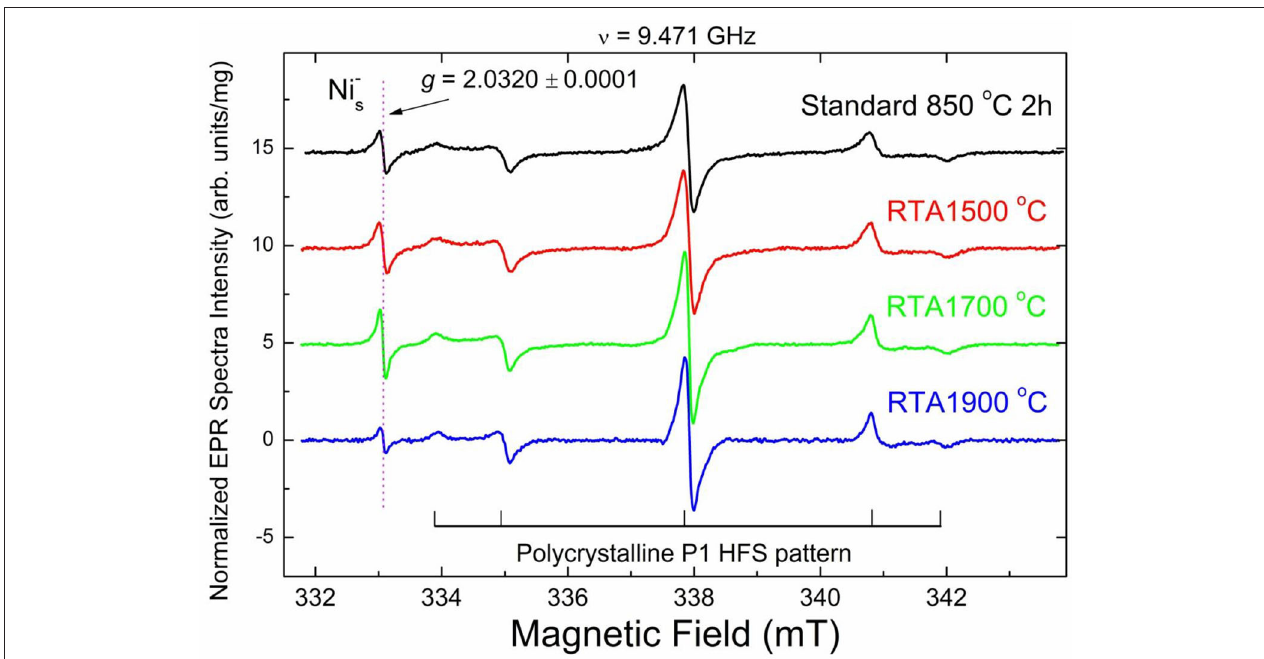
FIGURE 4 | High resolution X-band RT EPR spectra of 20 µ m diamond powders recorded at T = 50K, g = 2.00 region. Spectra were recorded at the same instrumental conditions: incident microwave power P MW = 2 µ W, 100kHz magnetic field modulation amplitude A mod = 0.01 mT, receiver gain RG = 2 × 10 5 , number of scans n acq = 100, microwave frequency ν = 9.471 GHz. Intensity of each EPR signal is normalized per unit mass; spectra are vertically shifted for better presentation. Hyperfine P1 lines are partially saturated. Horizontal and vertical lines in the bottom indicate hyperfine split polycrystalline EPR pattern due to P1 centers characterized by g iso = 2.0024 ± 0.0001, A x = A y = 2.96 ± 0.02 mT, A z = 4.06 ± 0.02 mT; central hyperfine line overlaps with two singlet lines having by g iso = 2.0028 ± 0.0001; arrow indicates position of a singlet line with g = 2.0320 ± 0.0001 attributed to Ni − s defects.